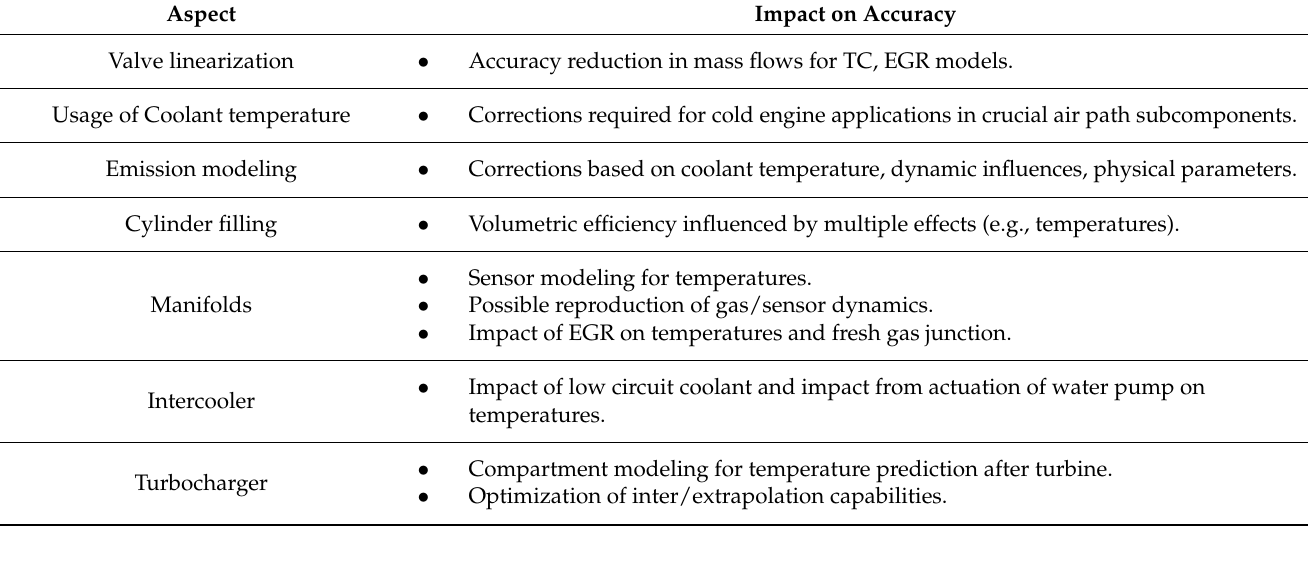
Table 8. Modeling potential for air path models.